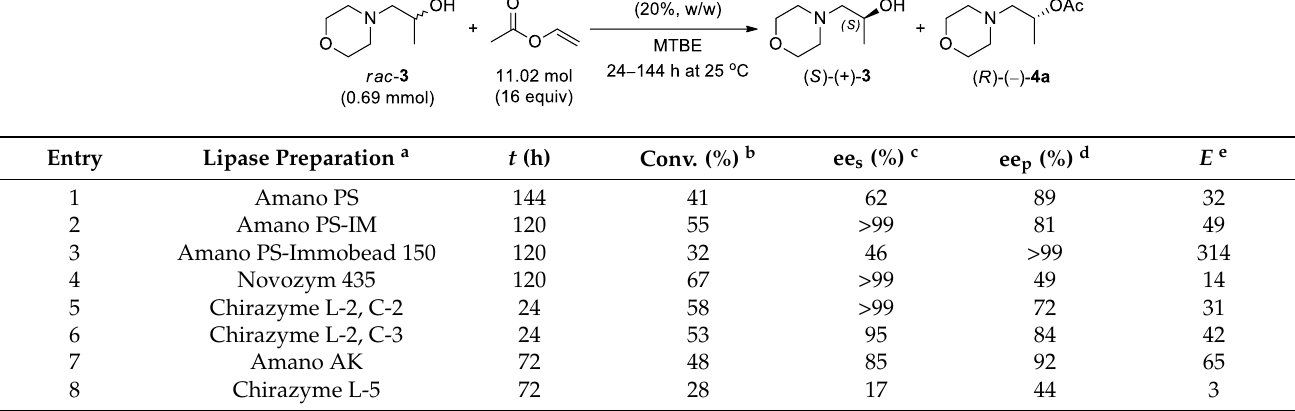
Table 1. Lipase screening for the kinetically controlled enantioselective acetylation of rac - 3 using vinyl acetate.